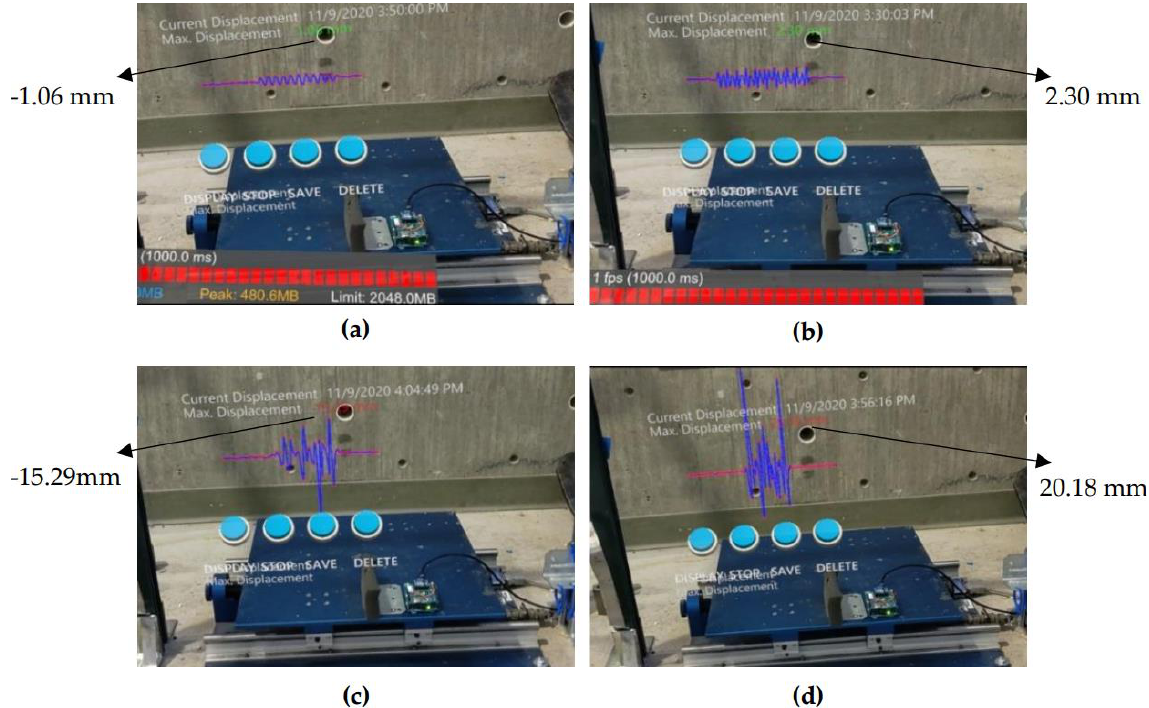
Figure 21. Real-time displacement visualization of different sensors through the HoloLens interface [11].